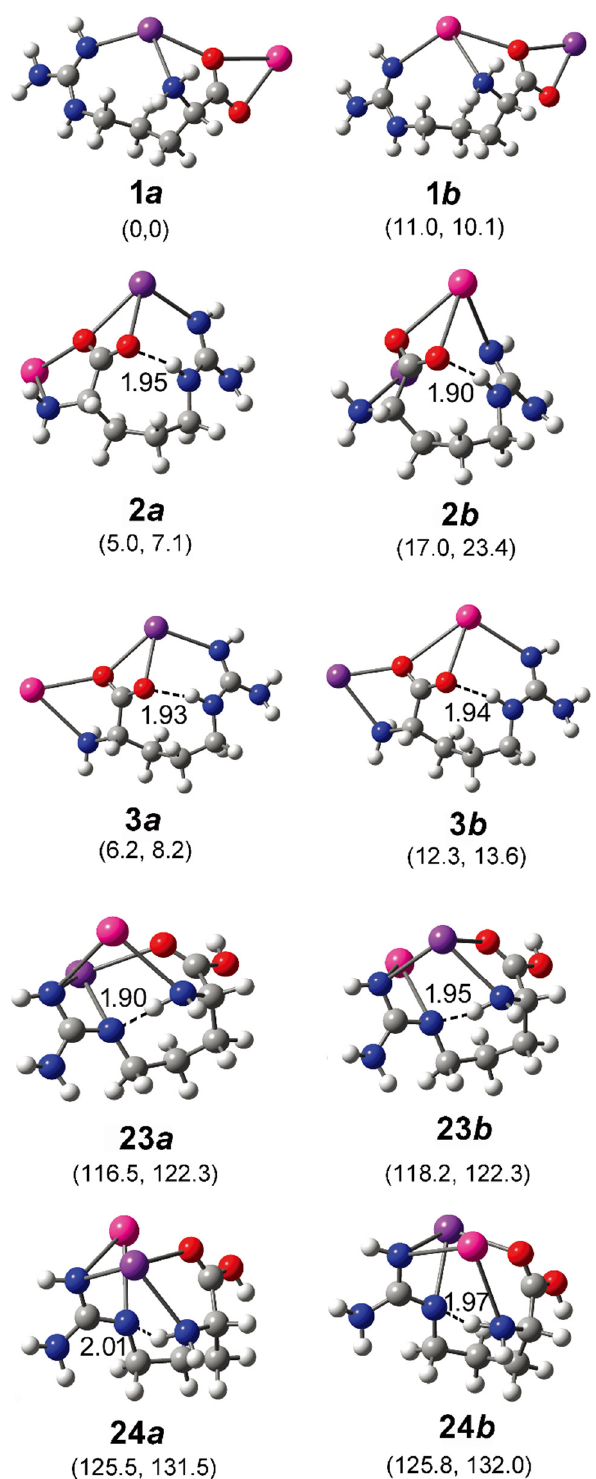
Figure 3. Some optimized isomers of [Arg+Rb+K−H] + at the level of B3LYP/6-311++G(d,p)~LAN. The most stable isomer is identified as 1 a . The relative energies at 0 K and Gibbs energies at 298 K relative to those of 1 a are shown in the parentheses below each subfigure (in kJ/mol). The distance of each intramolecular H-bond (in Å) is shown too. The pair of isomer a and b are obtained by exchanging the positions of Rb and K atoms and re-optimization. The atoms of K, Rb, O, N, C, and H are colored by purple, pink, red, blue, gray, and light gray, in turn.